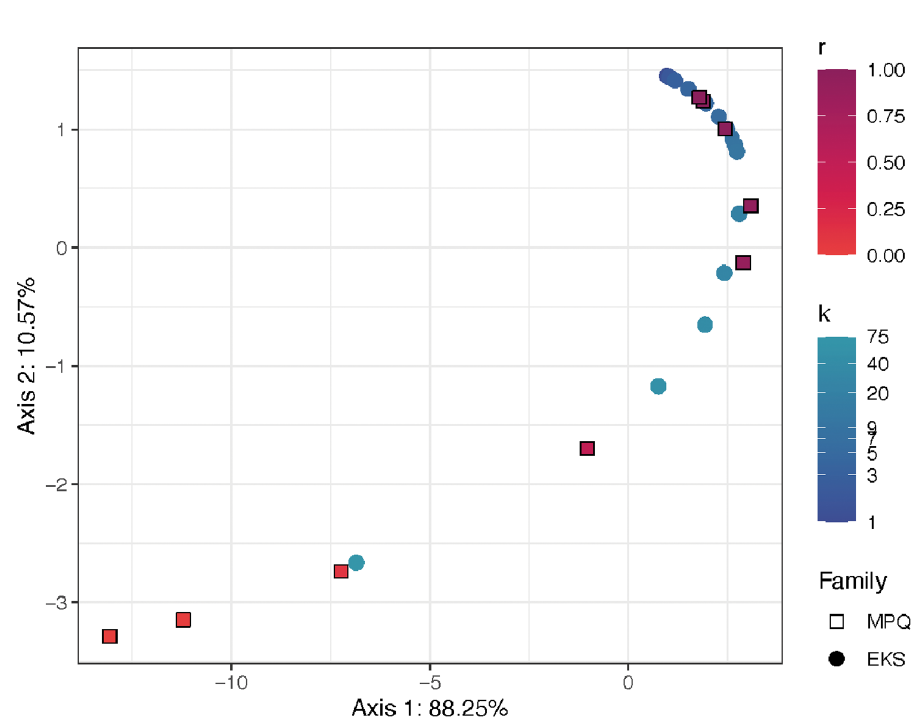
Fig 9. DISTATIS representation of the relationships among the EKS distances and MPQ distances. Each point represents a distance matrix describing the relationships among the samples in the colon cleanout dataset. Points corresponding to similar distance matrices are positioned close together in the plot. Squares represent EKS distance matrices, and circles represent MPQ distance matrices. Color represents the parameter ( k or r for the EKS distances and MPQ distances). Darker colors represent larger values of k /smaller values of r , while lighter colors represent larger values of r /smaller values of k .